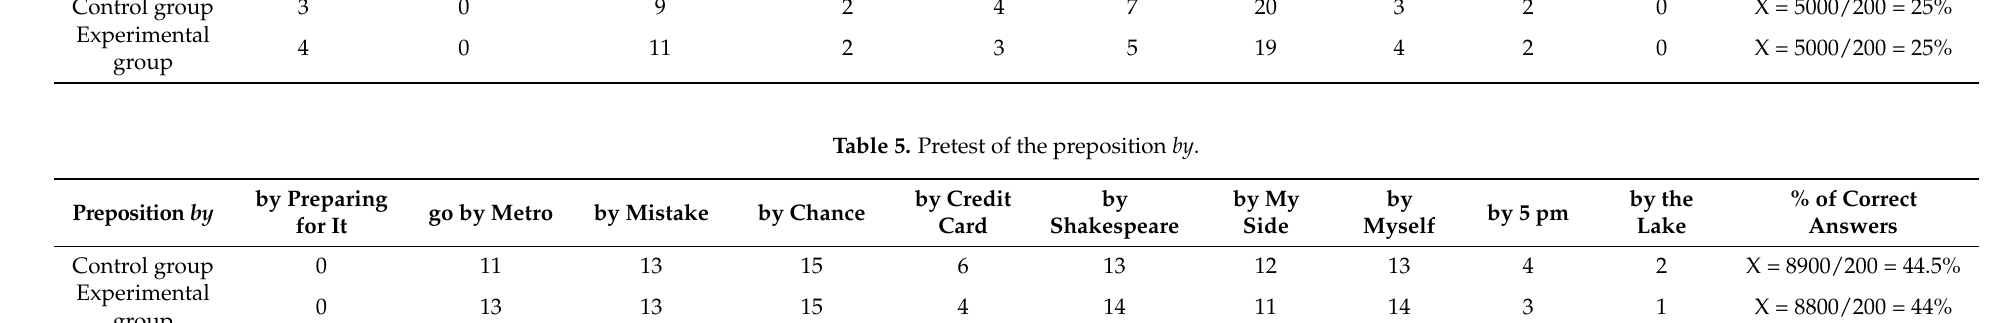
Table 9. Posttest 1 for the preposition by .